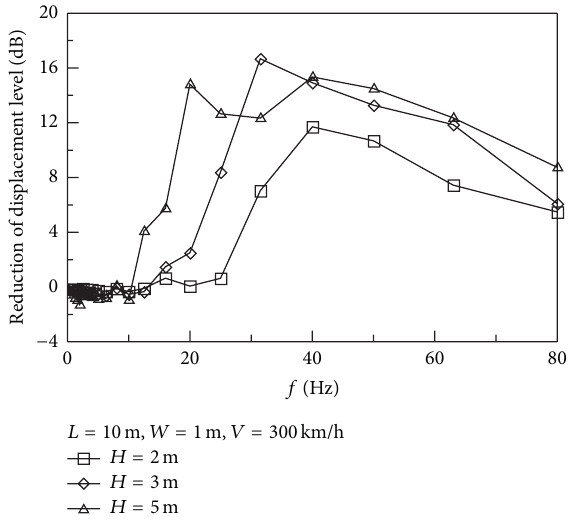
Figure 13: Influence of trench depth on